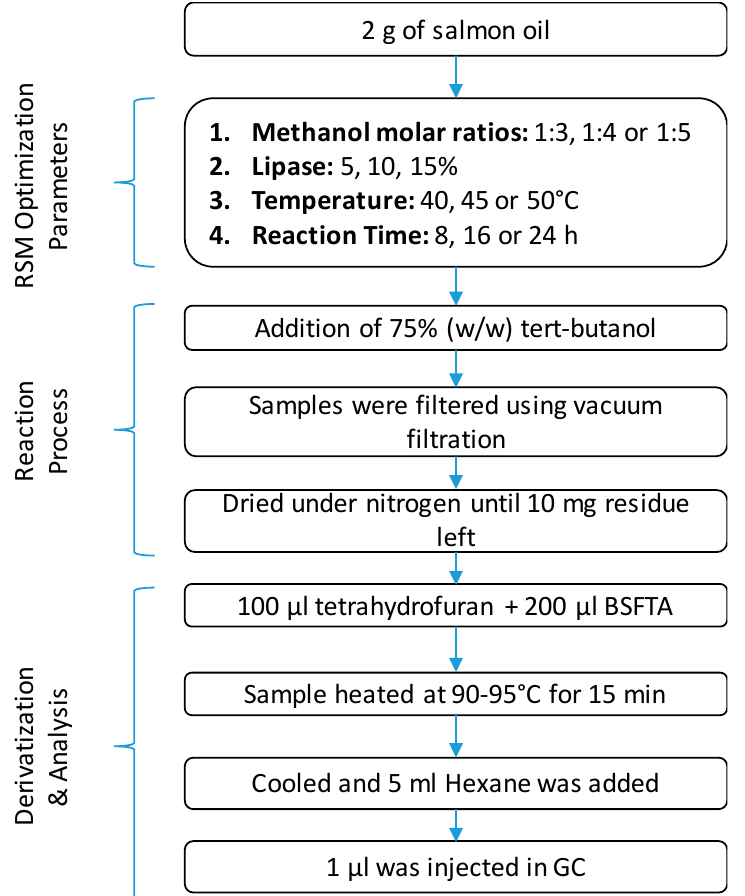
Figure 1. Experiment design of enzymatic transesterification of salmon oil for production of biodiesel.